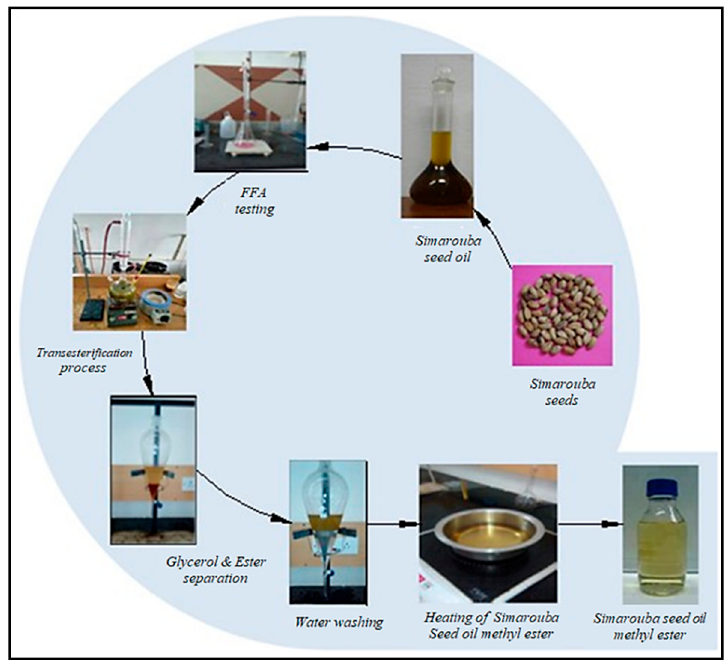
Figure 1. Steps involved in the transesterification